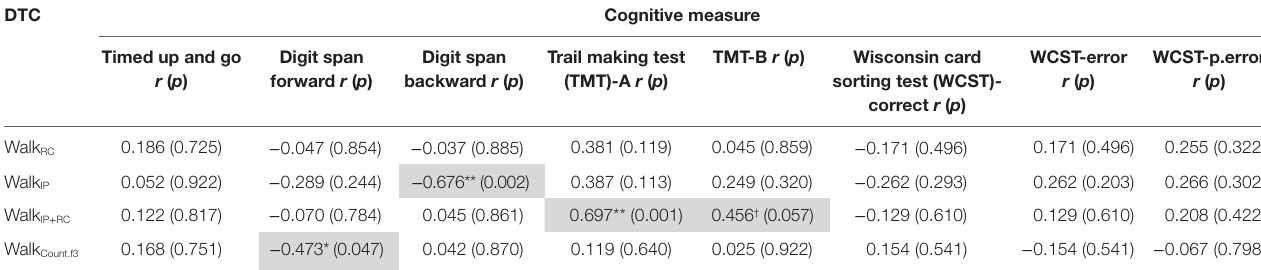
TaBle 7 | Correlation between dual task costs (DTC) in walking speed and cognitive